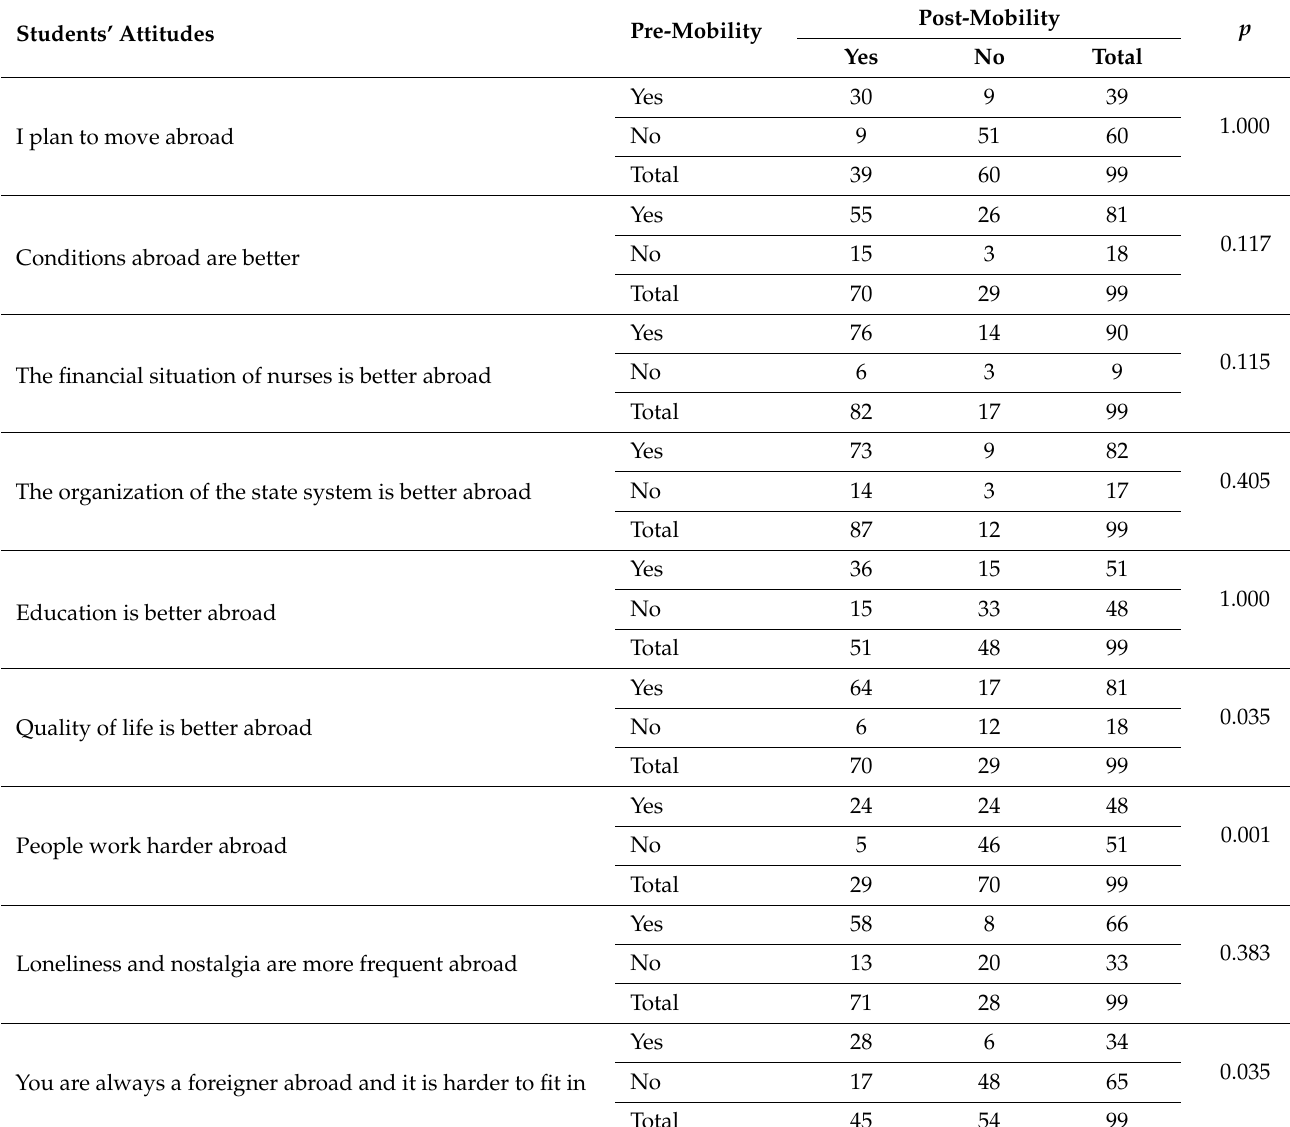
Table 4. Participants’ attitudes regarding certain statements in the context of international